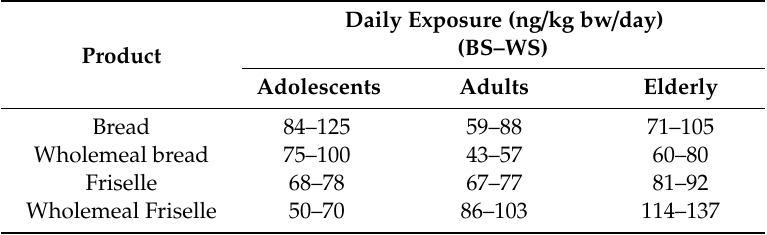
Table 4. Daily intake of acrylamide (AA) of median consumers according to the two scenarios considered in this study (BS = best scenario; WS = worst scenario).